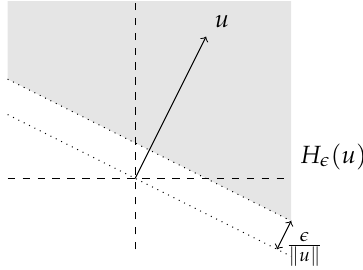
Figure 3. Shaded area representing H (cid:101) ( u )